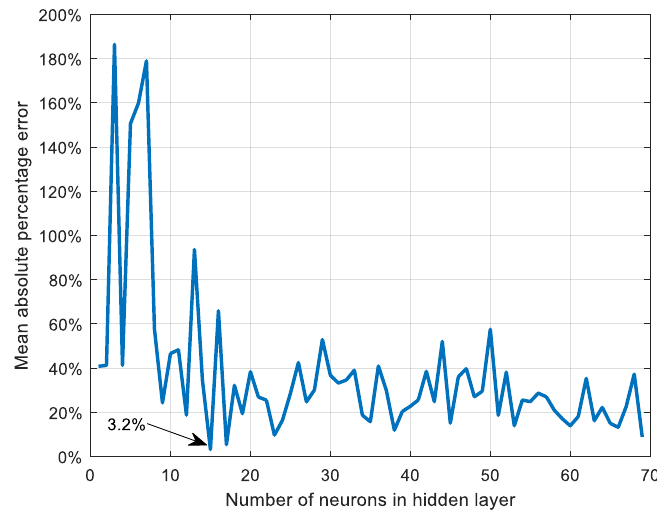
Figure 4. Performance of neural networks for the testing subset based on mean absolute percentage error (MAPE) criteria.